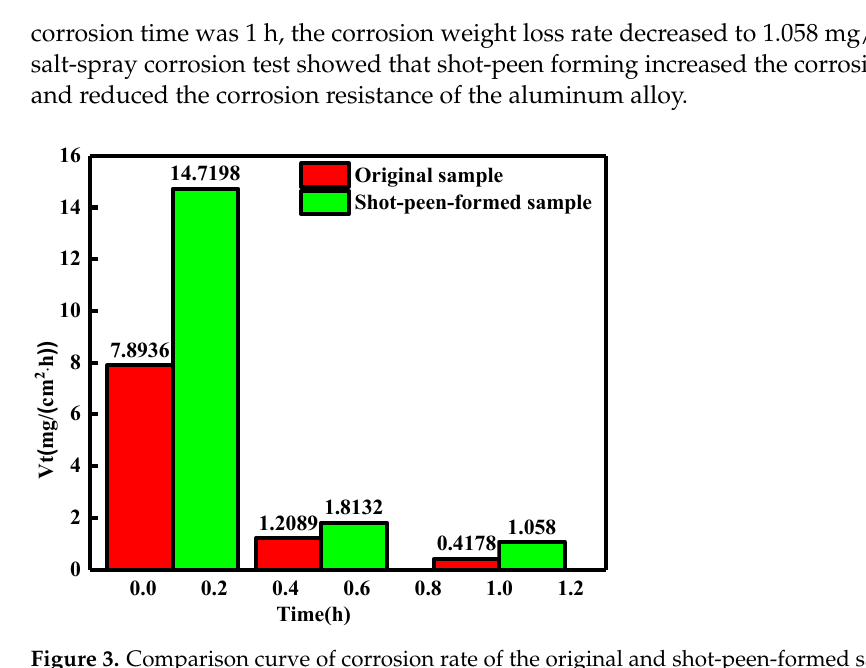
Figure 3. Comparison curve of corrosion rate of the original and shot-peen-formed samples.